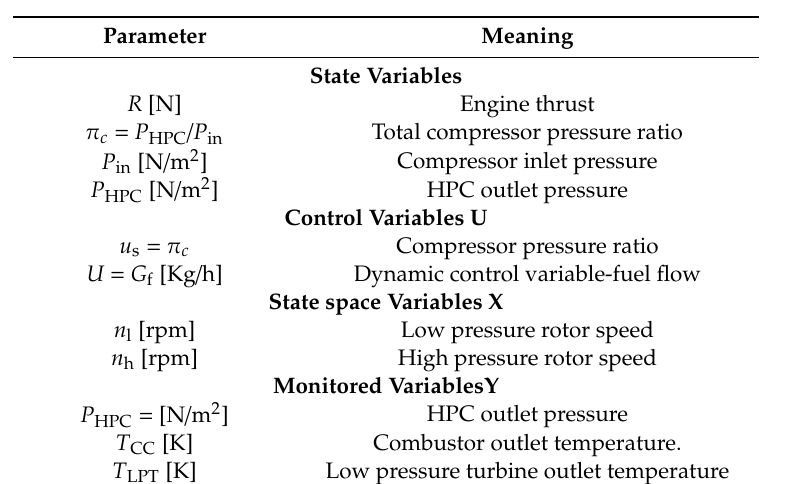
Figure 1. Turbofan scheme. Table 1. Simulated turbofan